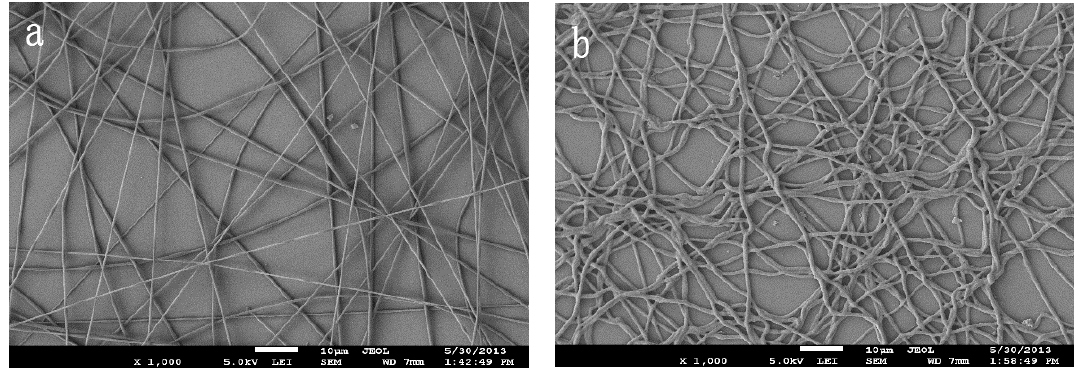
Figure 2. SEM morphology of nanofibers (( a ) before cross-linking; and ( b ) after cross-linking).